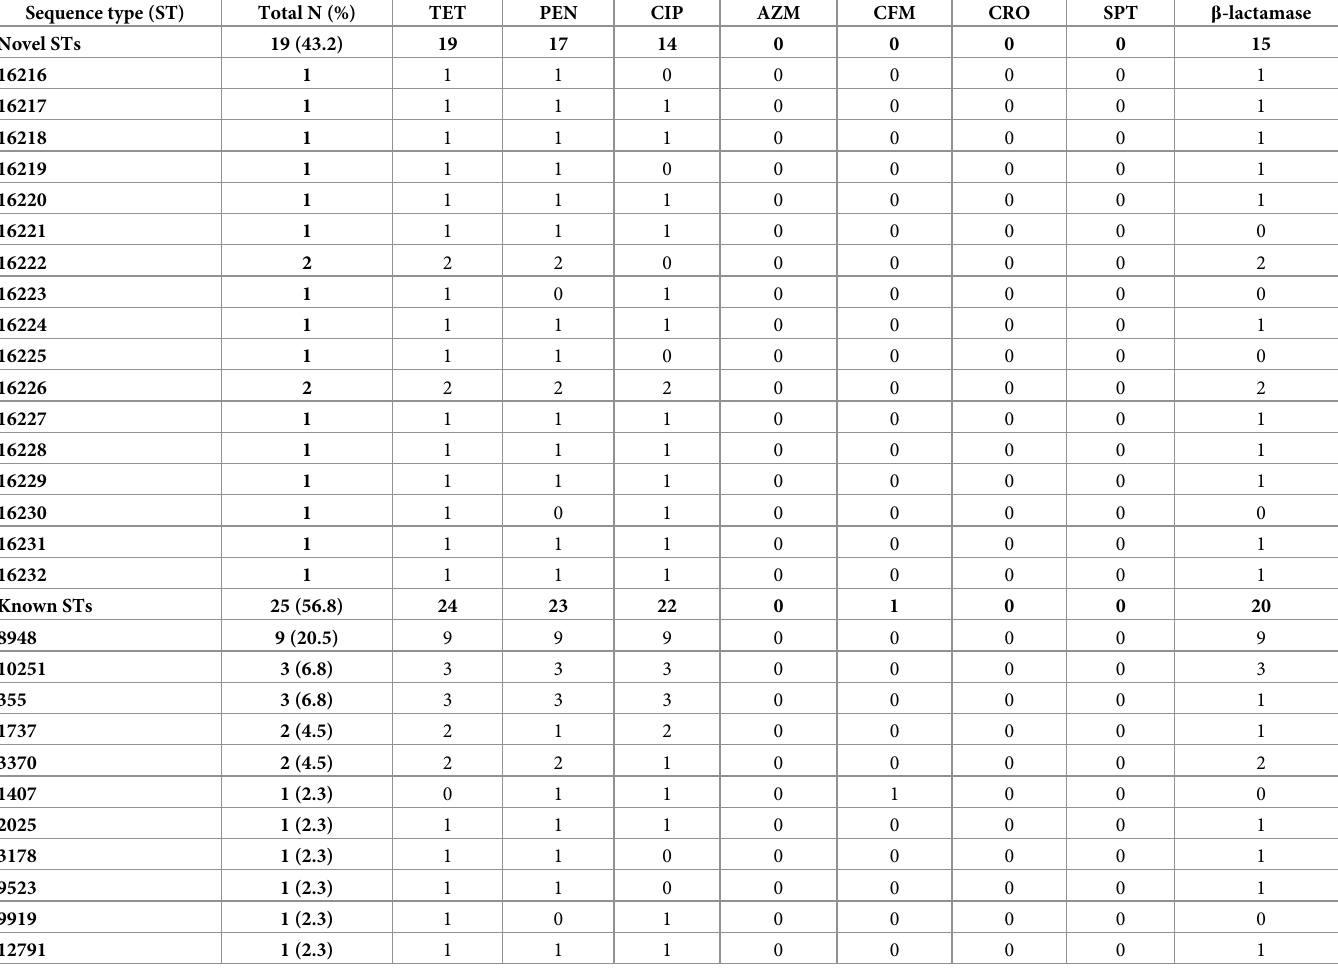
Table 2. Neisseria gonorrhoeae multiantigen sequence types (NG-MAST) of 44 N . gonorrhoeae isolates obtained in Ghana in 2012–2015, including antimicrobial resistance profile of each sequence type